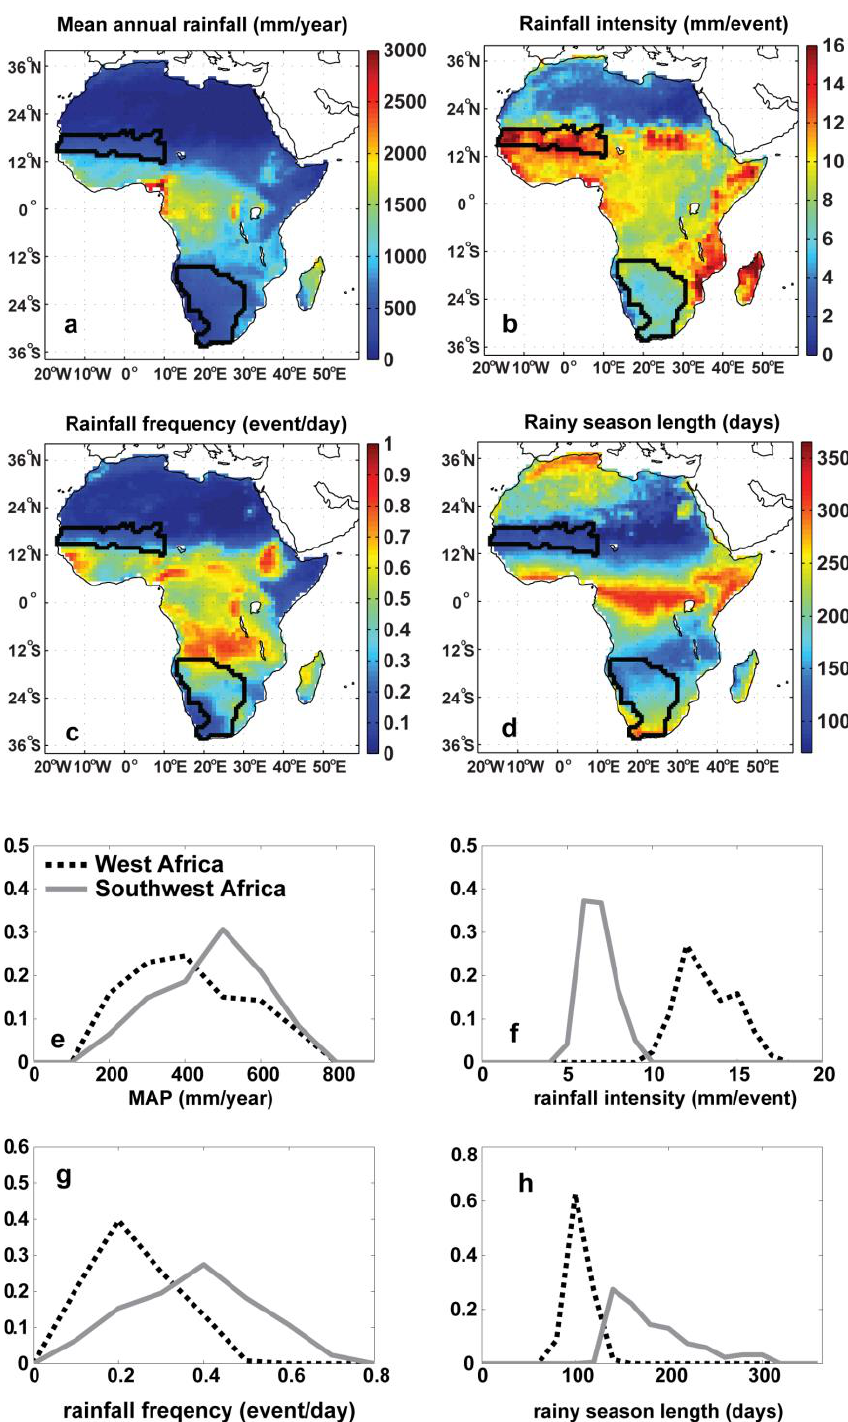
Figure 1. a-b: Spatial pattern of the rainfall characteristics in Africa: a-MAP; b-rainfall Figure 1. (a–b) Spatial pattern of the rainfall characteristics in Africa: (a) Mean annual precipitation (MAP); (b) rainfall intensity; (c) rainfall frequency; (d) rainy season length. The areas identified by the black line refer to two savanna regions in west and southwest Africa. (e–f) intensity; c-rainfall frequency; d-rainy season length. The black-line identified areas refer to Normalized histograms of the rainfall characteristics in two savanna regions of west and southwest Africa. (e) MAP (bin width for the x axis: two savanna regions in West and Southwest Africa. e-f: Normalized histograms of the rainfall 100mmyear − 1 ); (f) rainfall intensity (bin width for the x axis: 1mm event − 1 ); (g) rainfall frequency (bin width for the x axis: 0.1 event day − 1 ); (h) rainy season length (bin width for the x axis: 20 characteristics in two savanna regions of West and Southwest Africa. e-MAP (bin width for the x-axis: 100 mm/year); f-rainfall intensity (bin width for the x-axis: 1 mm/event); g-rainfall frequency (bin width for the x-axis: 0.1 event/day); h-rainy season length (bin width for the x-axis: 20 days).